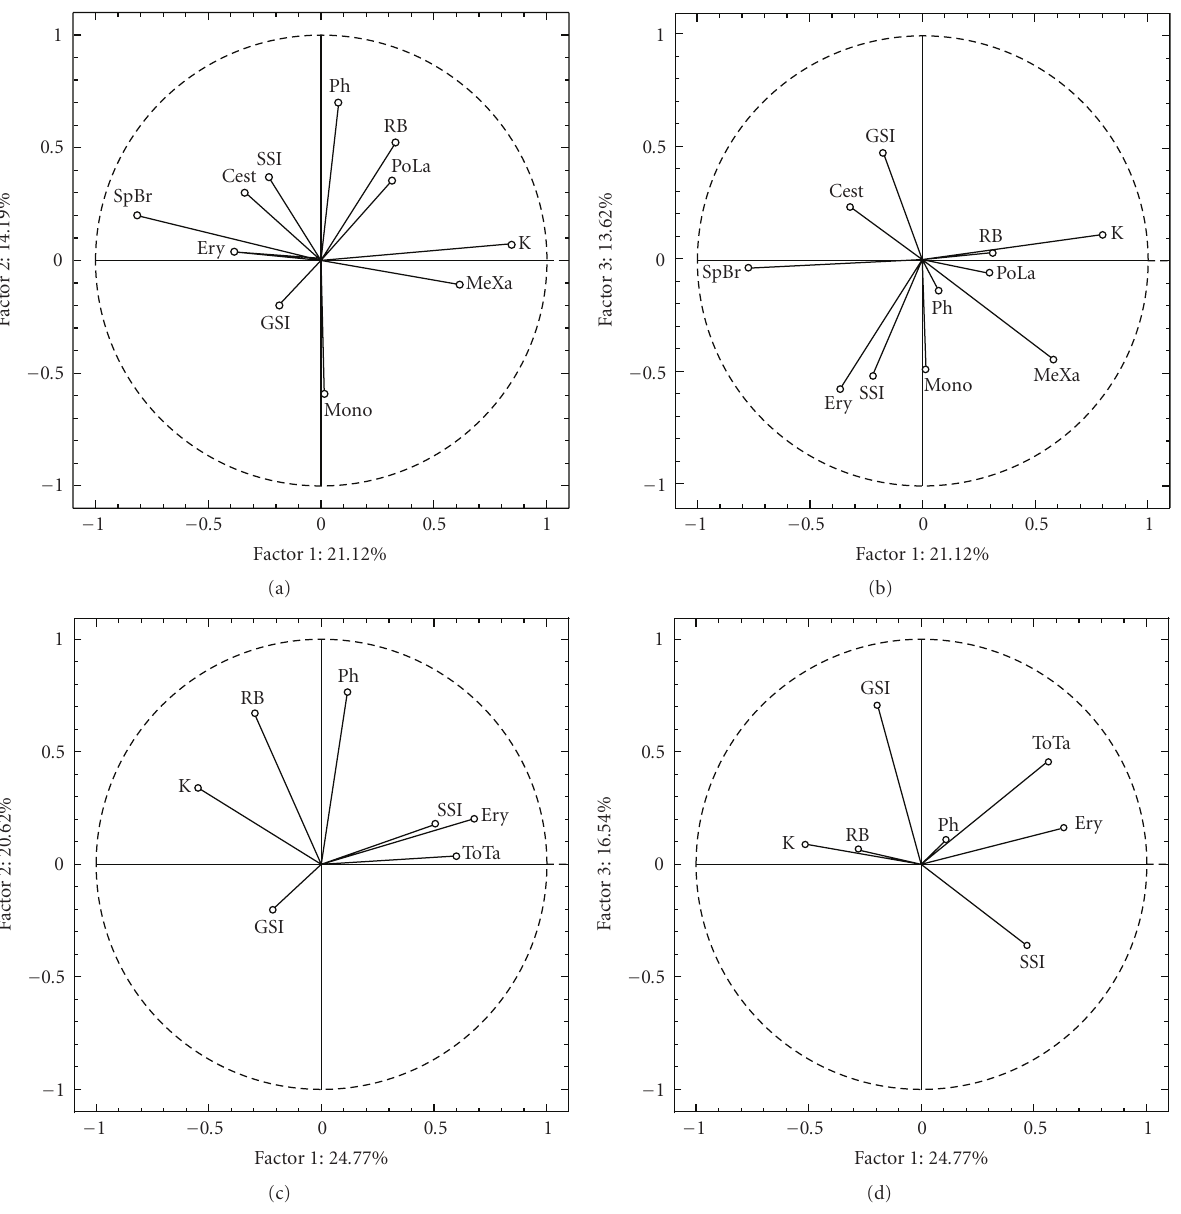
Figure 2: Principal component analysis (PCA) to evaluate the associations within physiology, immunity, and parasitism in before-breeding period. K : condition factor; GSI: gonado-somatic index; SSI: spleen-somatic index; RB: respiratory burst; Ph: phagocyte count; Ery: erythrocyte count; Mono: Monogenea; Cest: Cestoda; MeXa: Metorchis xanthosomus ; SpBr: Sphaerostomum bramae ; PoLa: Pomporhynchus laevis ; ToTa: total parasite species